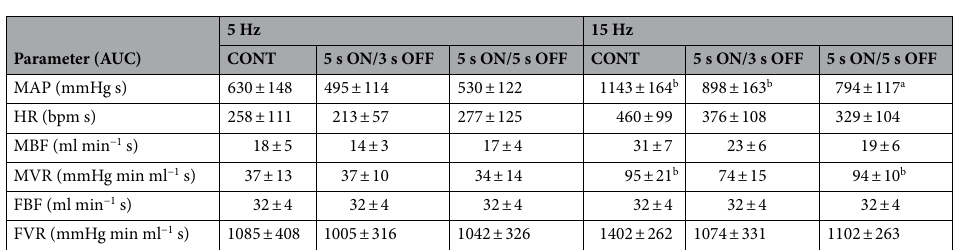
Table 2. Total area under the curve (AUC) for hemodynamic measures recorded in response to continuous (CONT) and intermittent (5 s ON/3 s OFF and 5 s ON/5 s OFF) stimulation of the aortic depressor nerve (ADN) using low (5 Hz) and high (15 Hz) pulse frequencies delivered for 20 s at 0.4 mA and 0.2 ms in pentobarbital-anesthetized spontaneously hypertensive rats. The data are presented as mean ± SEM ( n = 4–9) and were analyzed by a two-way ANOVA followed by Bonferroni’s post hoc test. MAP mean arterial blood pressure, HR heart rate, MBF mesenteric blood flow, MVR mesenteric vascular resistance, FBF femoral blood flow, FVR femoral vascular resistance. a P < 0.05 versus continuous stimulation for each frequency. b P < 0.05 versus respective stimulation across frequencies.